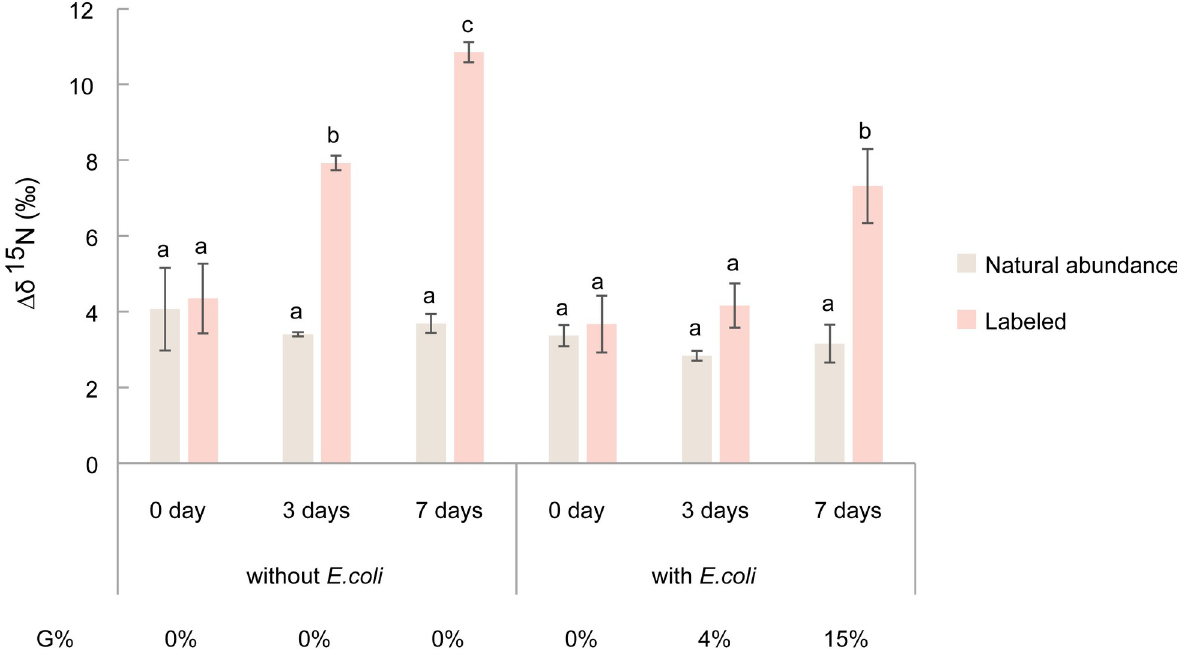
Fig 4. 15 N enrichment ( Δδ 15 N) of P . brassicae resting spores incubated with potassium nitrate with (+ E . coli ) or without (- E . coli ) the presence of E . coli suspension and corresponding germination rates (G%) after different incubation times. Error bars indicate standard deviations. Different letters represent significant differences among the treatments (Tukey test. P < 0.05, n = 3).